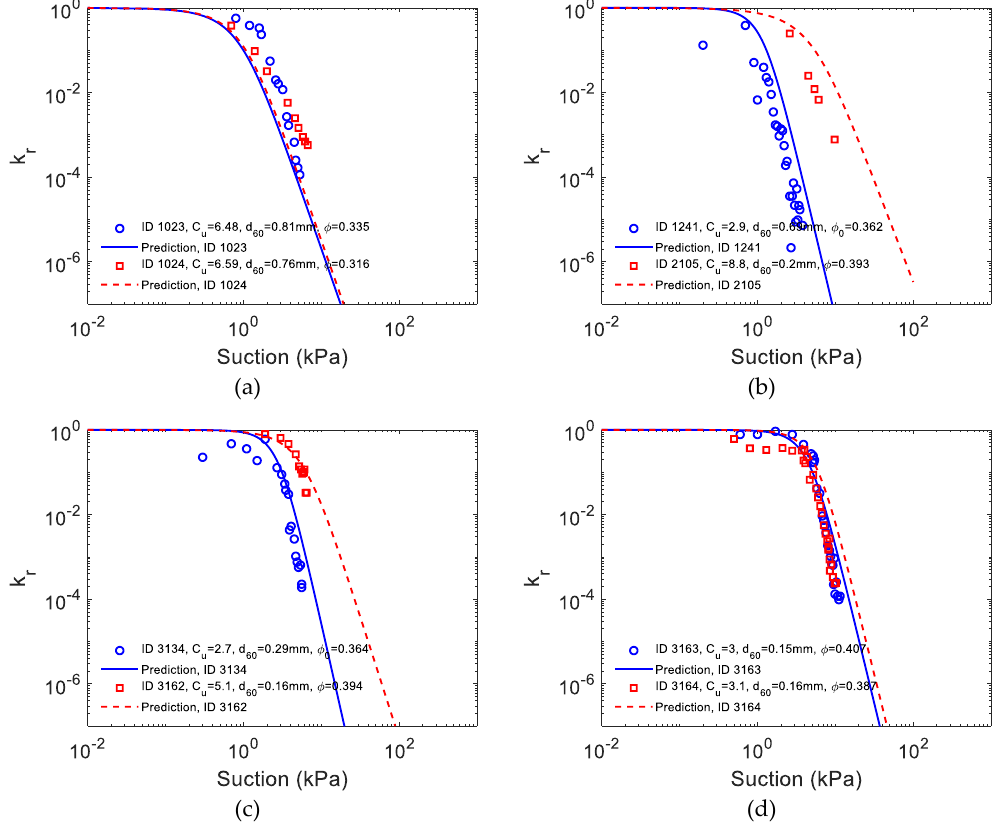
Figure 10. Comparisons between the corrected model predictions and instantaneous profile method measured results of relative permeability of sands in the UNSODA database. ( a ) sands 1023 and 1024; ( b ) sands 1241 and 2105; ( c ) sands 3134 and 3162; ( d ) sands 3163 and 3164.